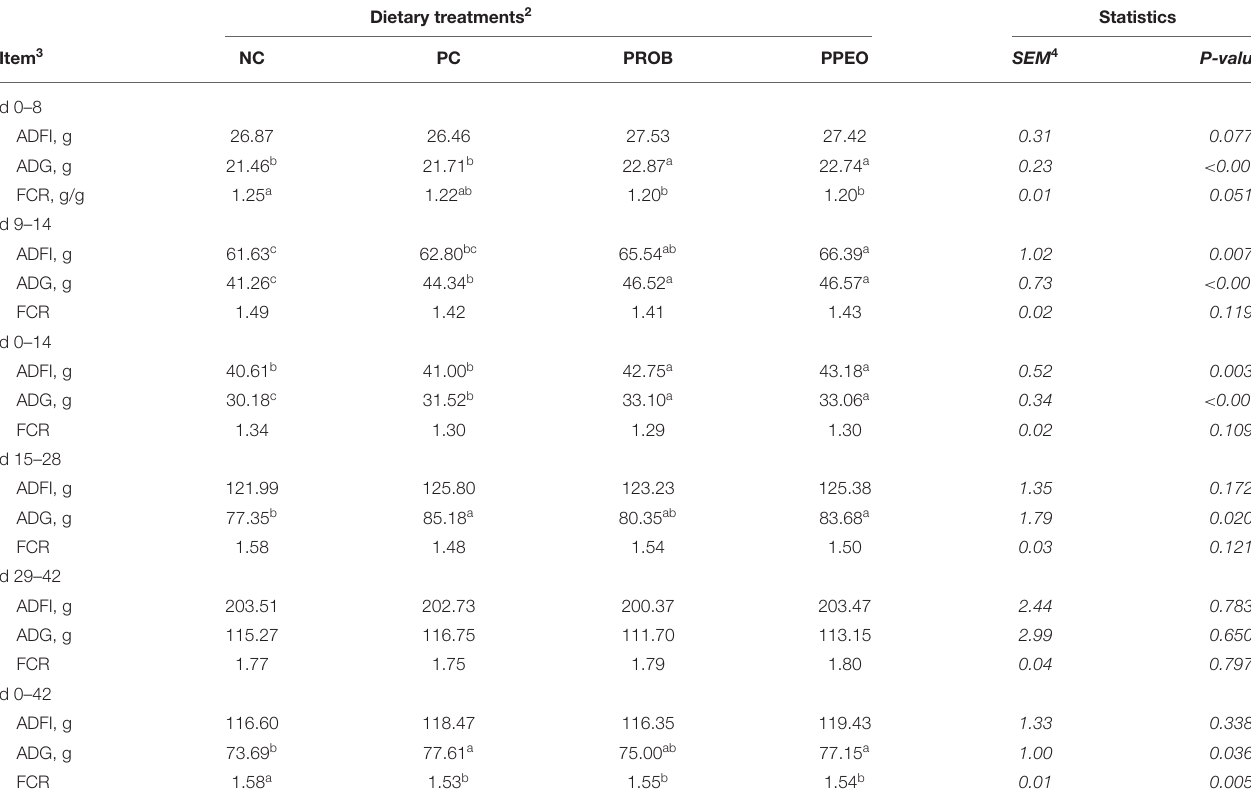
TABLE 5 | Effect of dietary probiotic (PROB) or probiotic/prebiotic/essential oil (PPEO) supplementation on broiler performance under a naturally occurring subclinical necrotic enteritis model 1 . Dietary treatments